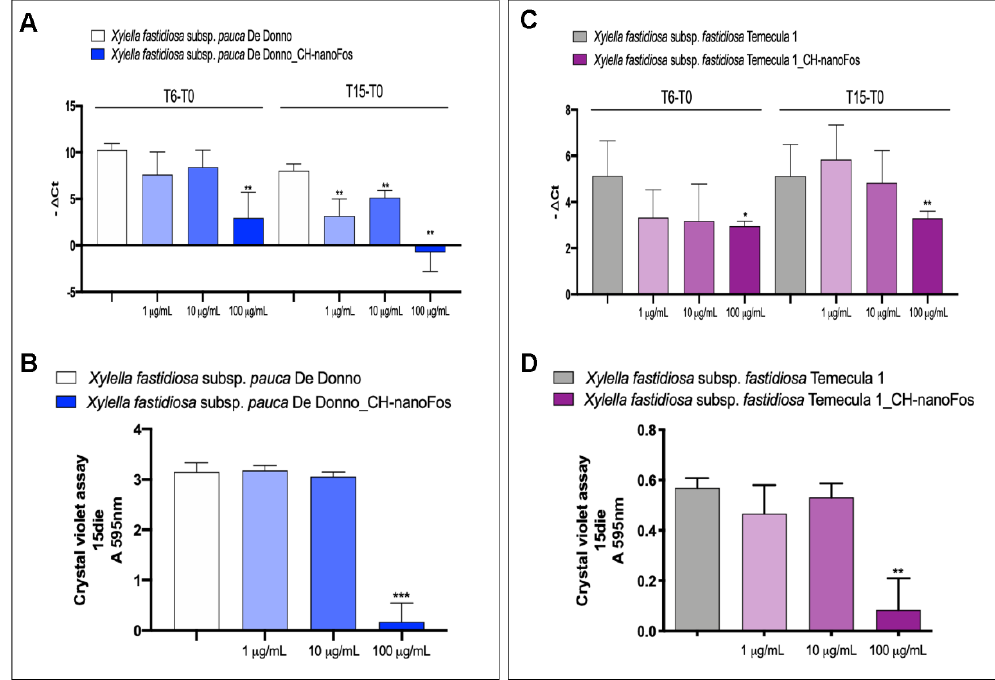
Figure 7. Fosetyl-Al and chitosan-based fosetyl-Al nano-formulations efficacy on Xfp strain De Donno (left panel) and Xff strain Temecula1 (right panel) planktonic growth and biofilm production. Efficacy of CH-nanoFos (100 µg/mL, 10 µg/mL and 1 µg/mL) on Xfp strain De Donno and Xff strain Temecula1 planktonic growth ( A , C ) and biofilm production ( B , D ). CH-nanoFos dilutions are reported in the